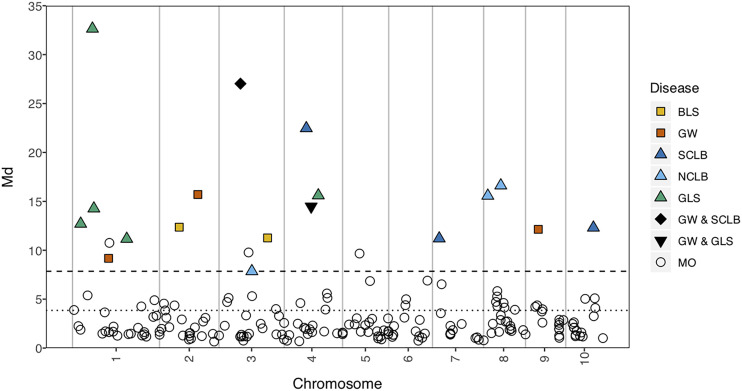
Manhattan plot for multivariate analysis. The mapping results for the two bacterial diseases are represented with warm colors and the three fungal diseases in cold colors. The GW&SCLB and GW&GLS symbols indicate that the same SNP is significantly associated with both diseases. The MO symbol corresponds to the markers that were not significant in the single-trait mapping analysis but were significant in the multi-trait composite analysis. The dotted line indicates the 1% FDR for the Md statistic. The dashed line represents the Md value for the minimum LOD threshold for the five mapping analyses.